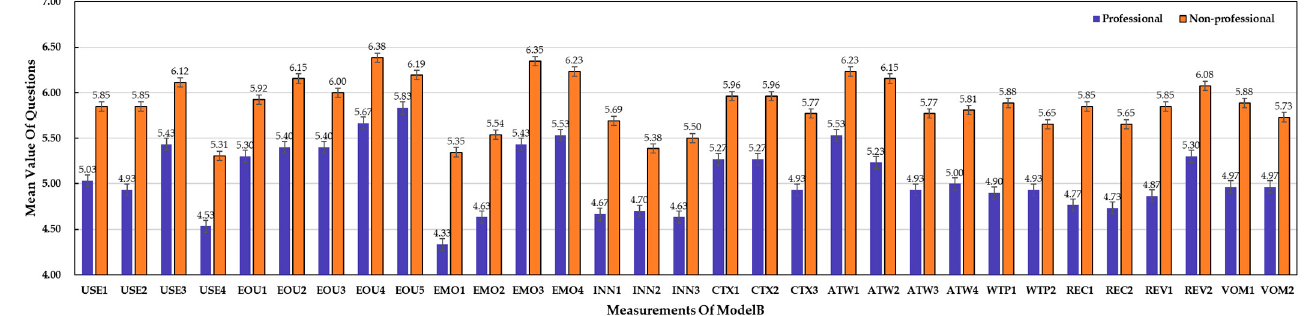
Figure 10. Comparison results of all measurements of Model B between professional and non-professional groups.